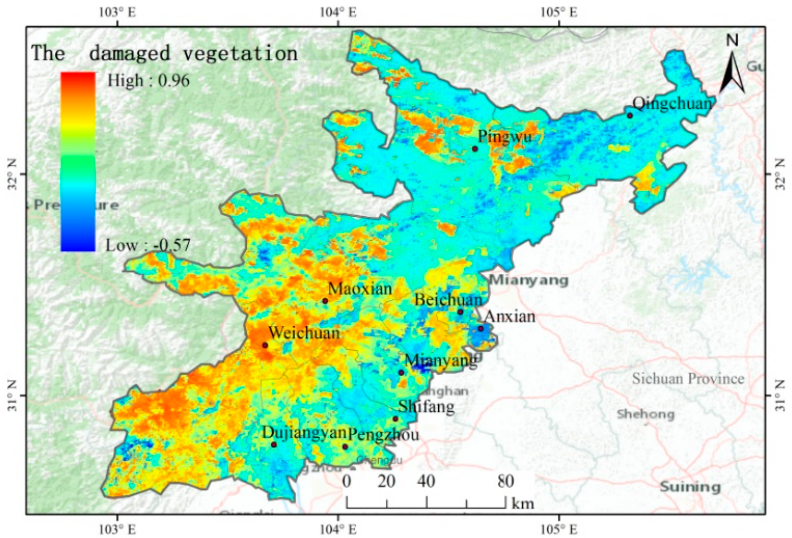
Figure 7. Analysis of vegetation damage in the core area of the Wenchuan earthquake.